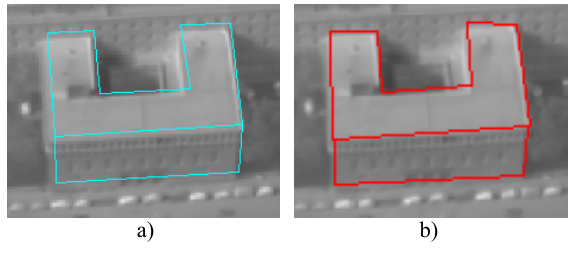
Figure 6. Local matching: a) initial position; b) position after local